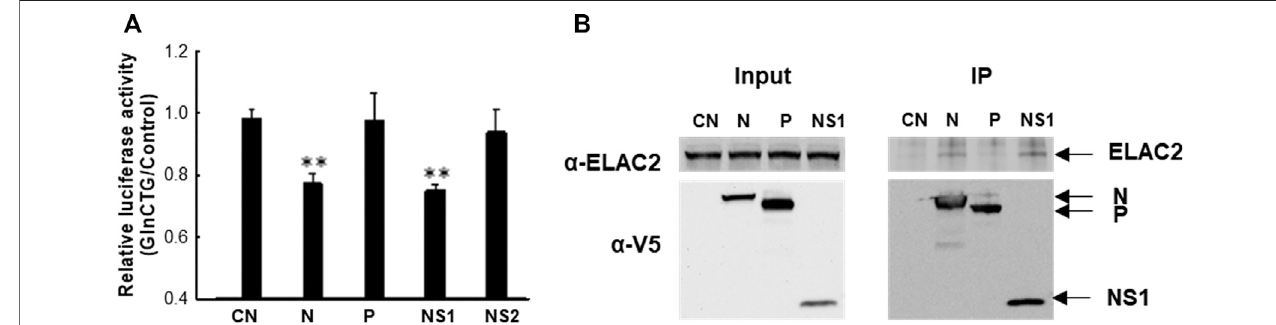
FIGURE4| ThecontributionofRSVproteins totheinductionoftRF5-GlnCTG. (A) A549cellsintriplicateweretransfectedwithplasmidsencodingV5-taggedRSV N, P,NS1,NS2, orempty vector(CN, negative controlforviral protein expression).Vectors of Pp -anti_GlnCTG_WT(containing thetarget sequenceoftRF5-GlnCTG) or Pp -anti_Control (without tRF5-GlnCTG target sequence) were also co-transfected with renilla luciferase plasmids ( Rr , luciferase expression internal control). At 30 h post-transfection, the cells were harvested for the dual-luciferase assay. Pp luciferase values were normalized to their corresponding Rr luciferase values and then the normalized value of Pp -anti_GlnCTG_WT was normalized to that of Pp -anti_Control vector. Data are representative of three independent experiments. ** P < 0.01, relative to the fi rst bar. (B) 293 cells were transfected with individual V5-tagged viral proteins as indicated. CN and P-expressing plasmids were used as controls. After 30 h, the cells were harvested and immunoprecipitation was done using the anti-V5 antibody, followed by Western blot using the anti-ELAC2 and anti-V5 antibodies. Proper expression of ELAC2 and V5-tagged RSV proteins was con fi rmed in sample input. Data are representative of three independent